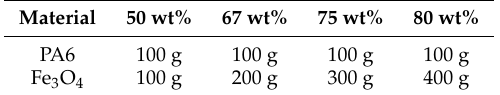
Figure 1. Fabrication process of the susceptor. Table 2. Masses of magnetite (Fe 3 O 4 ) and polyamide 6 (PA6) used to form different weight